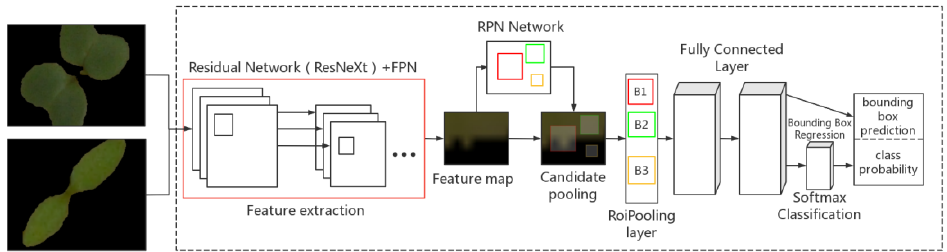
Figure 6. Improved model plots.